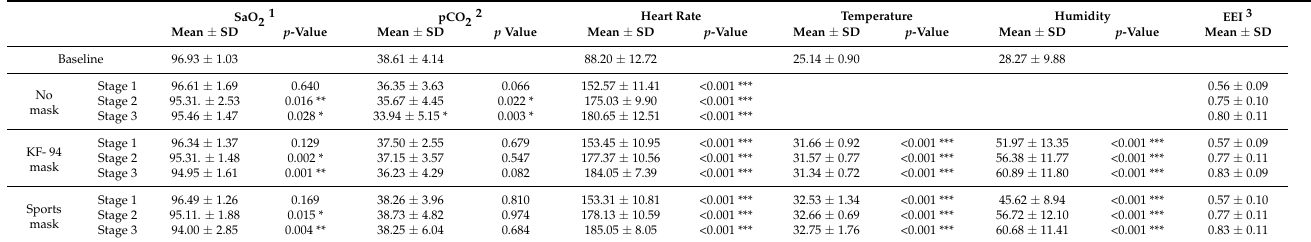
Table 1. Physiologic parameters in three conditions of mask wearing compared to baseline.